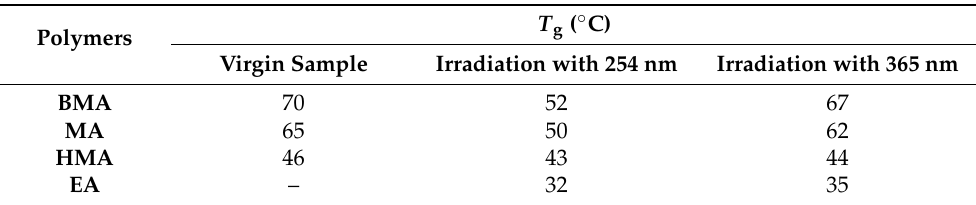
Table 2. Glass transition temperature ( T g ) of virgin and irradiated acrylate copolymers containing 3% 7-methacryloyloxy coumarin as photoreactive pendant groups.